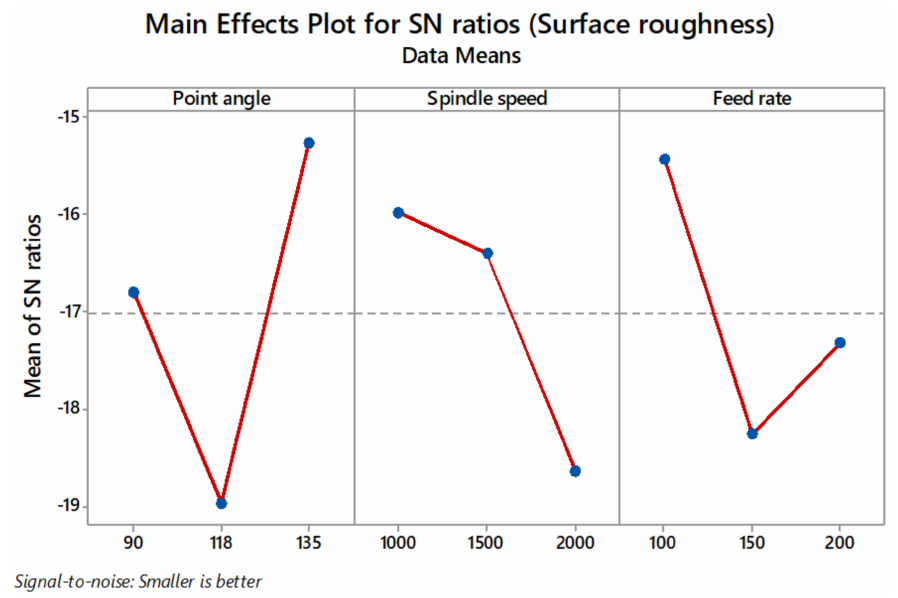
Figure 10. Main effect plot for S/N ratios of surface roughness (R a